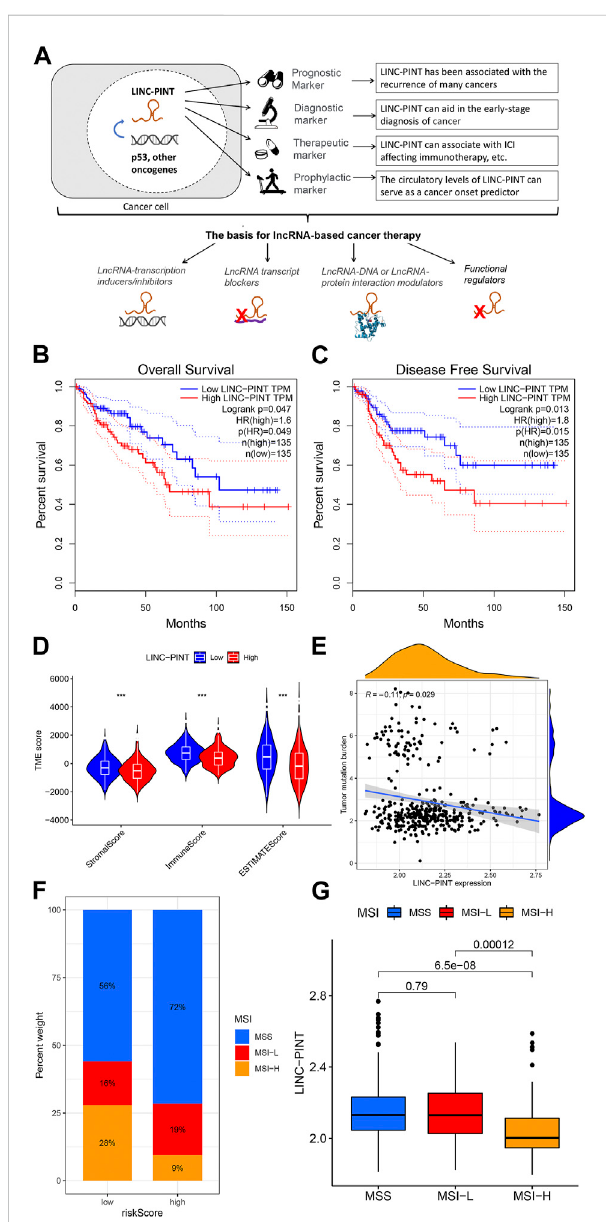
FIGURE 1 Clinical potentials of LINC-PINT. (A) Overview of the clinical applications of LINC-PINT. In short, it can be used as a prognostic marker to ascertain the course of cancer progression based on its expression level. It can also be used as a diagnostic marker to aid the early detection of ontological transformation. The third type of application,already inpre-clinicaltesting, predicts responseto cancer therapy. Finally, less explored but equally important is the potential of LINC-PINT-based studies to determine the susceptibility of healthy subjects to cancer. These applications can be used, in turn, to tailor and administer suitable lncRNA-based cancer therapies. Correlation of LINC-PINT expression with (B) Overall survival and (C) Disease-free survival in Colon Adenocarcinoma (D) Association of LINC-PINT expression with immune scores, including stromal, immune, and ESTIMATE scores, (E) Tumor Mutation Burden, and (F – G) microsatellite instability in colon adenocarcinoma